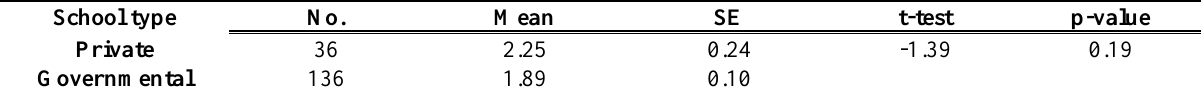
Table (3): The mean values and standard error of teeth with traumatic dental injuries among private and public